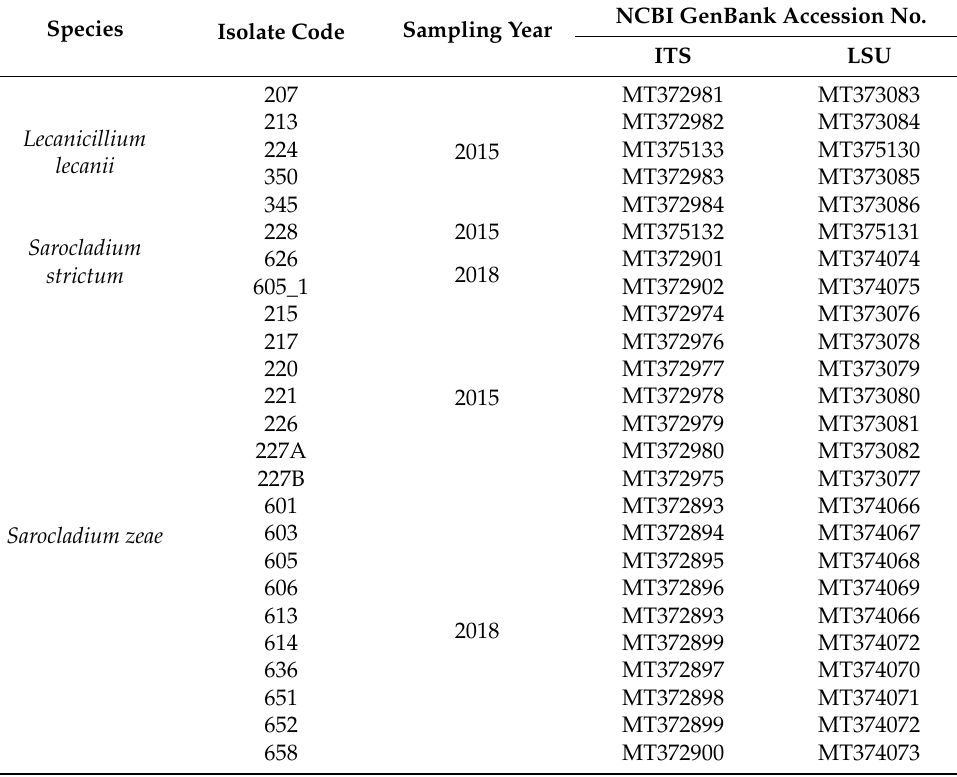
Table 1. The list of identified or re-identified in present study endophytic fungi isolated from maize ear samples collected in the Greater Poland